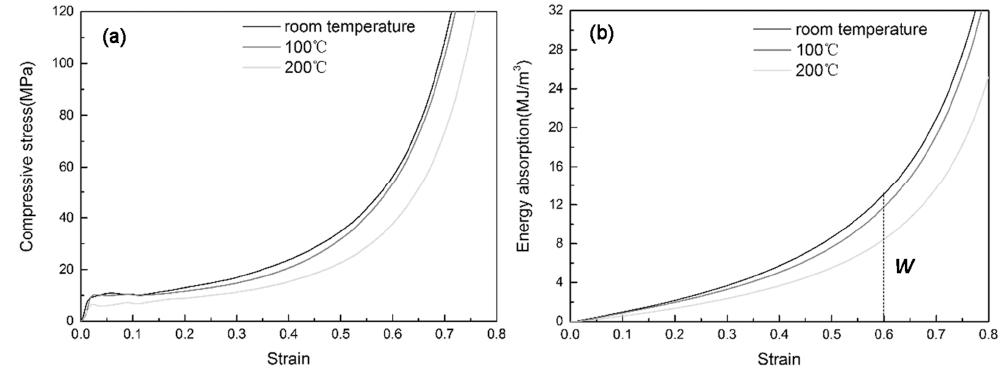
Figure 8. Compressive properties of composite foams at different temperatures: ( a ) stress–strain curves, ( b ) energy absorption capacity–strain curves.